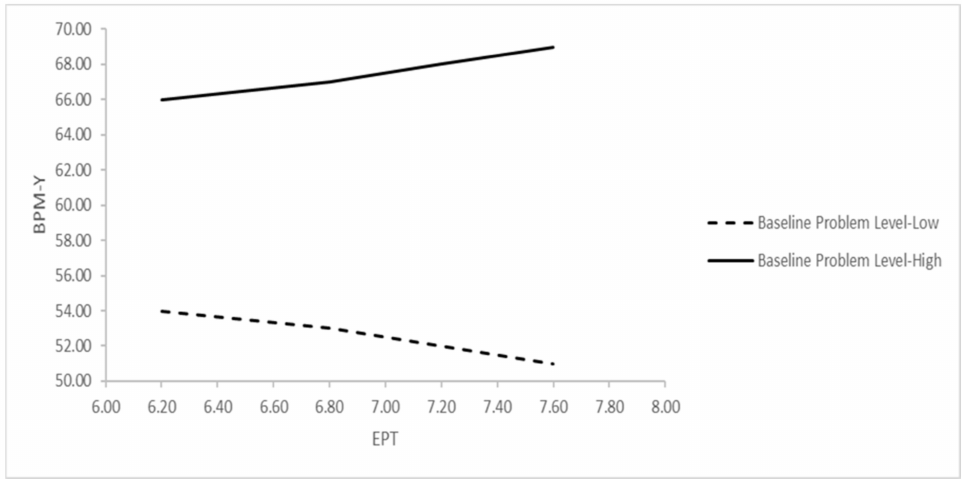
Figure 1. Interaction effect of EPT and YSR Total Problems on prediction of BPM-Y Total Prob- lems. Notes: BPM-Y = Brief Problem Monitor-Youth, EPT = Exploratory Psychodynamic Technique, YSR = Youth Self Report; “Baseline Problem Level–High” indicates 1 SD above, and “Baseline Prob- lem Level–Low” indicates 1 SD below the mean of pretreatment YSR Total Problems T